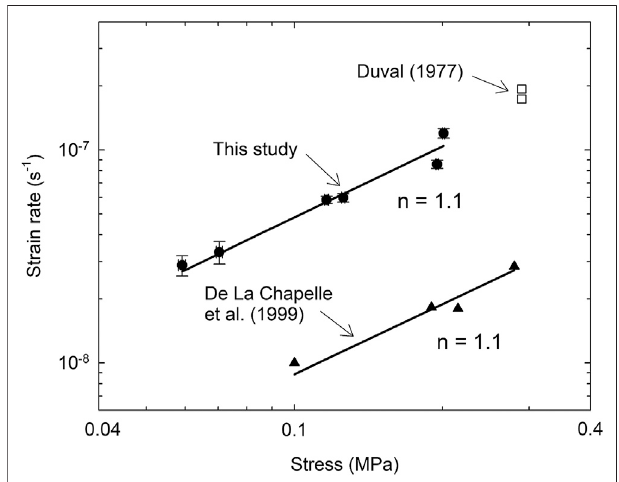
FIGURE 7 | Strain rate as a function of stress for experiments at water contents of 0.6 – 1.7%, compared with data from uniaxial compression tests on saline ice (2 mm grain size) with a water content of 7% and at a temperature of − 13 ° C (DeLaChapelleetal., 1999). Alsoshown arethetwostrainrates measuredinDuval ’ s(1977)studyatwatercontentsgreaterthan0.6%(the fi tted line excludes these points and implies A (cid:2) 6.21 × 10 − 7 Pa − 1.1 s − 1 in Eq. 2